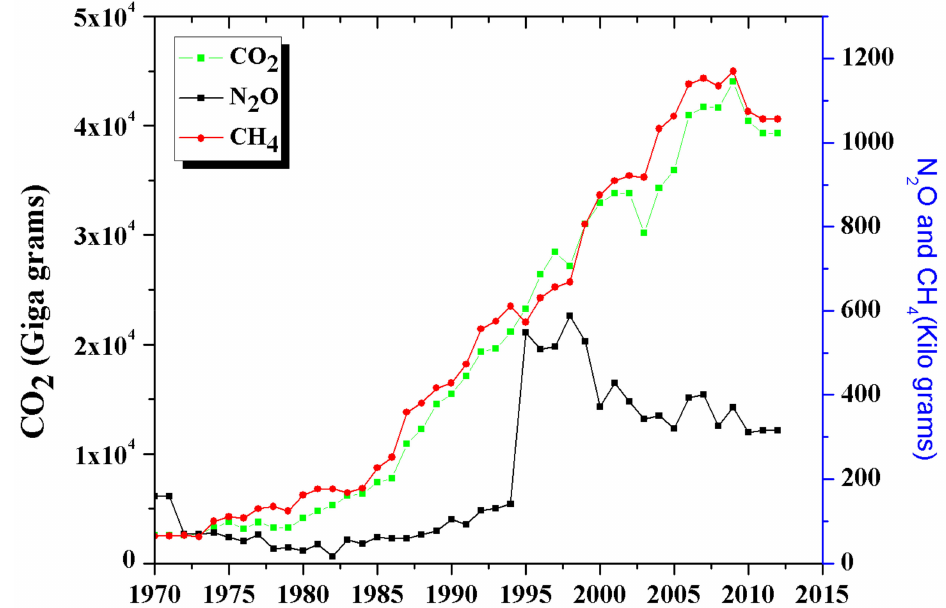
Figure 7. EDGAR estimates of the GHG emissions from the power sector in Pakistan.